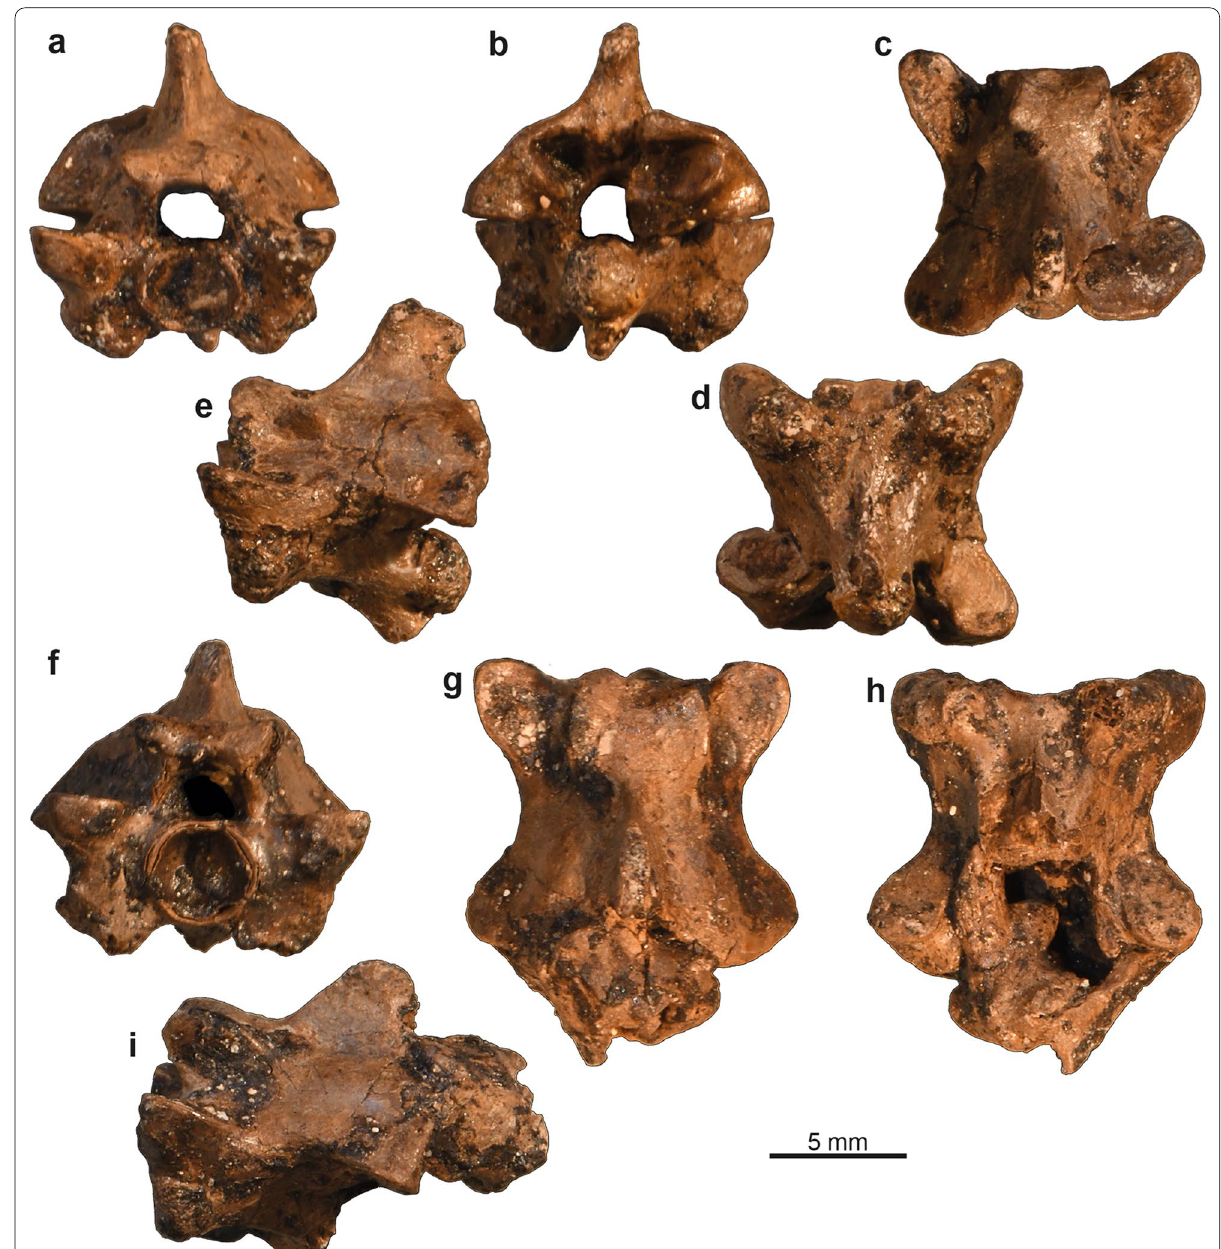
Fig. 73 Eoconstrictor spinifer comb. nov. from quarry Cecilie I, Geiseltal—paralectotype (GMH Ce I-5822-1926): a – e anterior trunk vertebra in anterior ( a ), posterior ( b ), dorsal ( c ), ventral ( d ), and left lateral ( e ) views; f – i anterior trunk vertebra (along with remains of the articulated succeeding vertebra) in anterior ( f ), dorsal ( g ), ventral ( h ), and left lateral ( i )